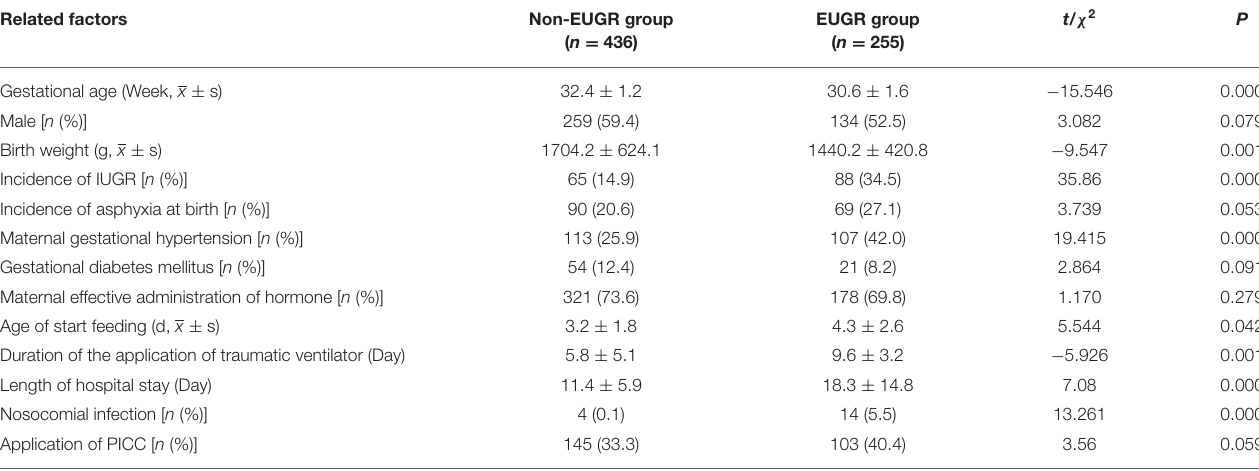
TABLE 4 | Comparison of the general characteristics at discharge in preterm infants with a gestational age < 34 weeks between the non-EUGR group and EUGR group. Related factors